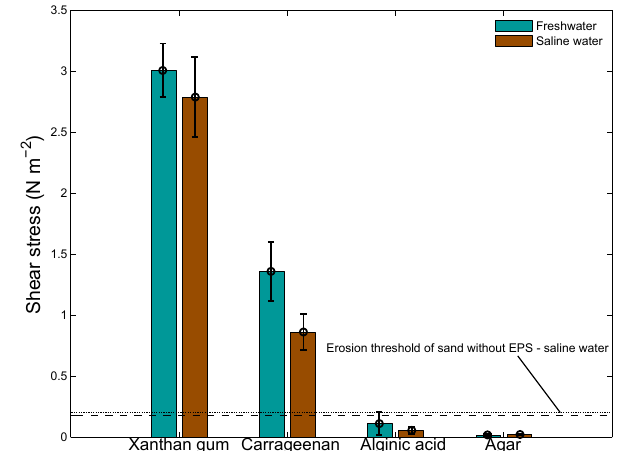
Figure 7. The threshold for erosion as a function of salinity for four extracted EPSs as measured with the CSM erosion device. Distilled water was used for the freshwater tests and a salinity of 30ppt was used for the saline water tests. The horizontal lines correspond to the threshold for erosion of sand without EPSs for freshwater (dashed) and saline water (dotted). Error bars are standard deviations from n = 3 repeat